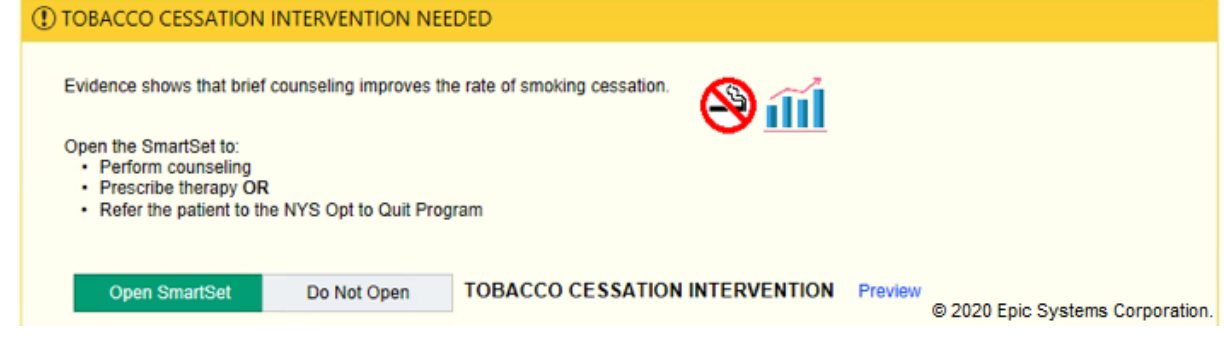
Figure 8. Tobacco evidence-based messaging alert with images tested in Round 2 of the randomized controlled trial. Copyright 2020, Epic Systems Corporation.